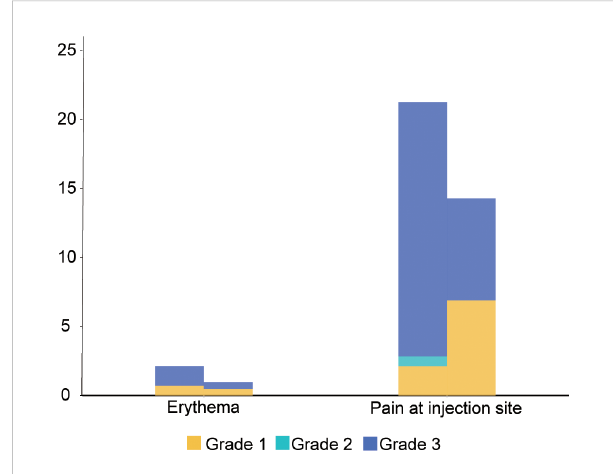
FIGURE 3 Related local adverse events between two cohorts.